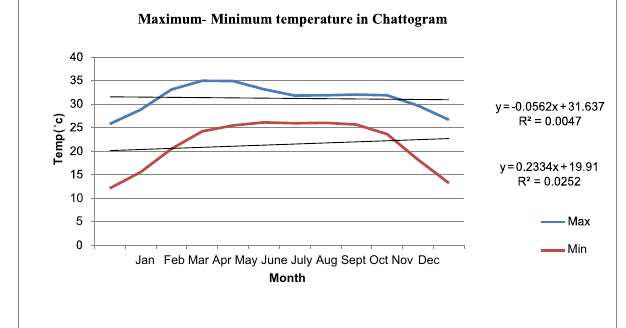
Figure 4: Long term (1950-2010) trend of maximum-minimum temperature in Chattogram.